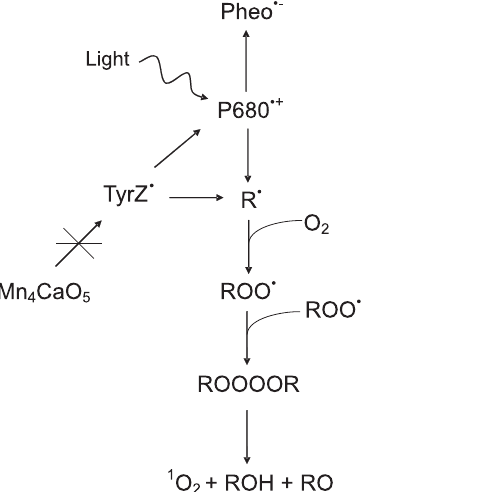
Figure 6. Proposed mechanism for the formation of 1 O 2 in the donor side photoinhibition of PSII. Carbon centered radical (R N ) formed by oxidation of lipids and proteins react with molecular oxygen to form peroxyl radical (ROO N ). Two peroxyl radicals react with the each other to form linear tetraoxide (ROOOOR) known to decompose to singlet oxygen ( 1 O 2 ), carbonyl (RO) and alcohols (ROH) via the Russell mechanism.